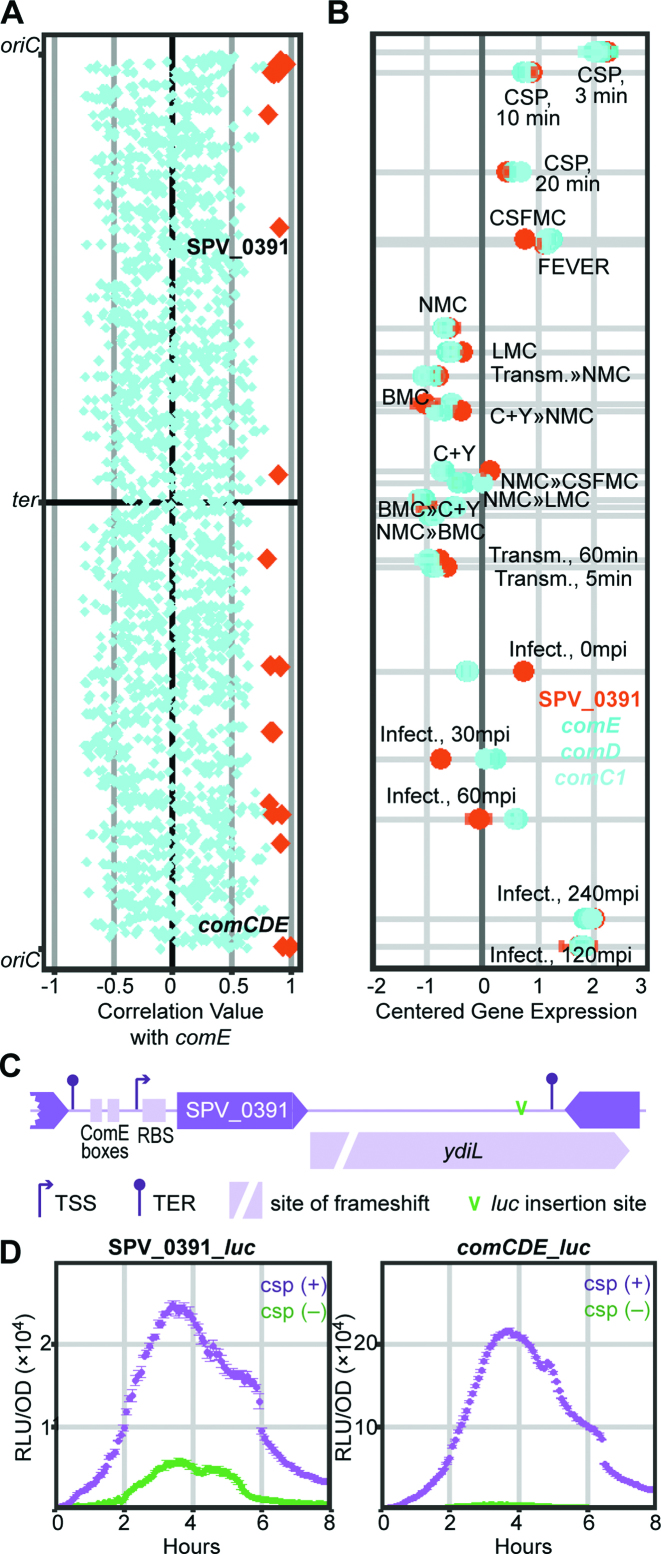
The co-expression matrix reveals a new competence-regulated gene. (A) The gene encoding the pneumococcal response regulator, ComE, was used to recover 26 highly correlated features (orange diamonds). The group is mainly populated by known members of the ComE regulon, except for SPV_0391, a conserved hypothetical gene not previously reported to be part of the competence regulon. (B) Centered regularized log as expression values of SPV_0391 (orange) and comCDE (shades of blue) were plotted against the shortest tour of infection-relevant conditions. Expression values of the four genes closely clustered together. (C) Genomic environment of SPV_0391 with two preceding ComE boxes. SPV_0391 shared an operon structure with a pseudogene, ydiL. (D) luc was transcriptionally fused downstream of SPV_0391 or comCDE to characterize their expression profiles with and without the addition of exogenous CSP-1 (100 ng/μl). The addition of exogenous CSP-1 incited similar luminescence profiles in SPV_0391-luc and in comCDE-luc strains.